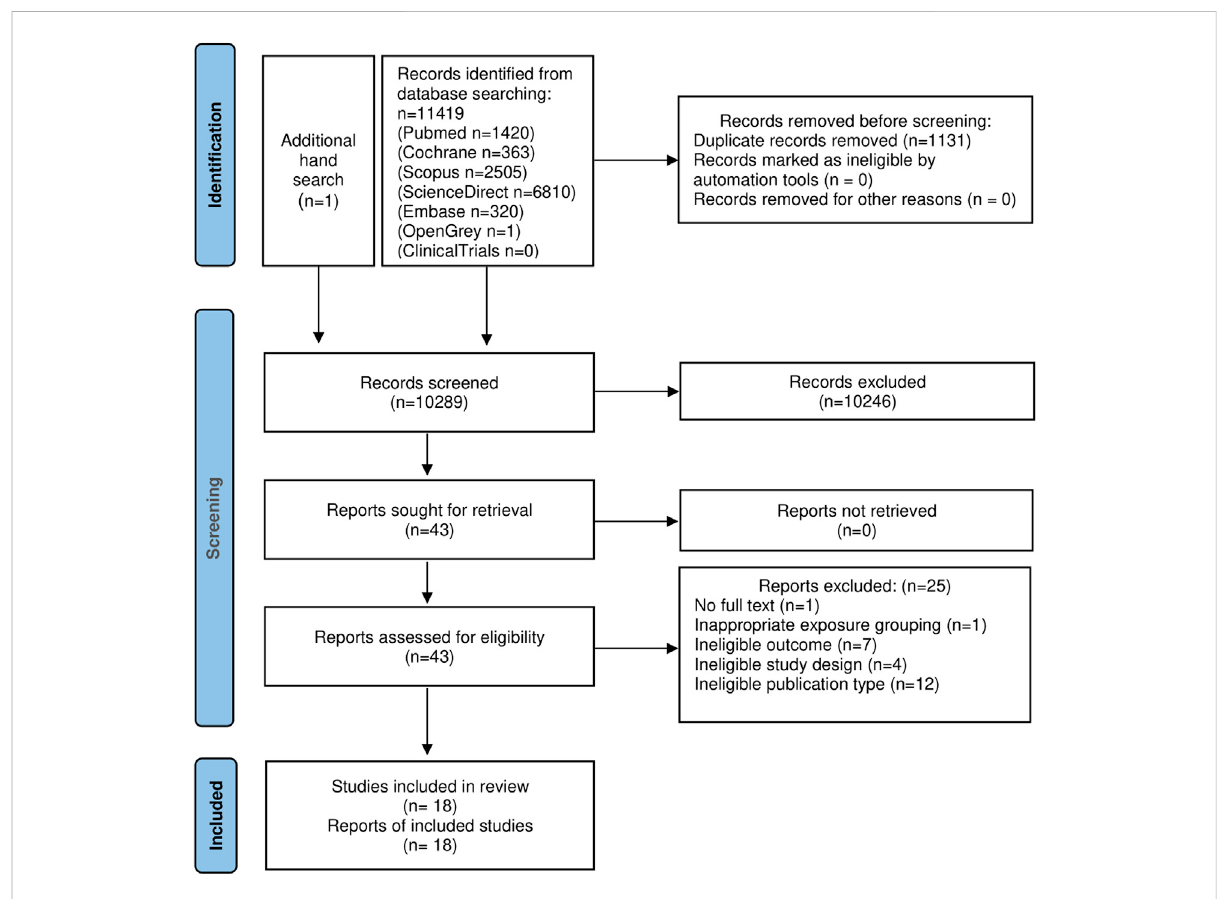
FIGURE 1 Flow diagram of the literature search in this